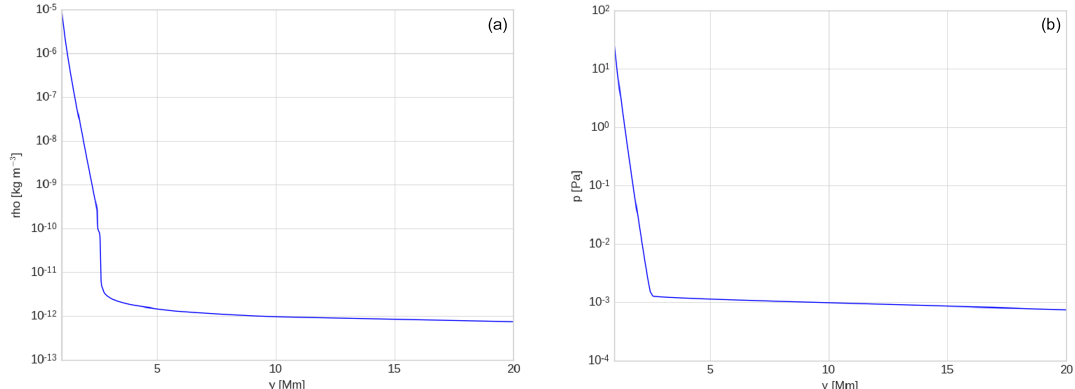
Figure 4. Equilibrium profiles of mass density (a) and gas pressure (b) vs. height in the model quiet solar atmosphere.